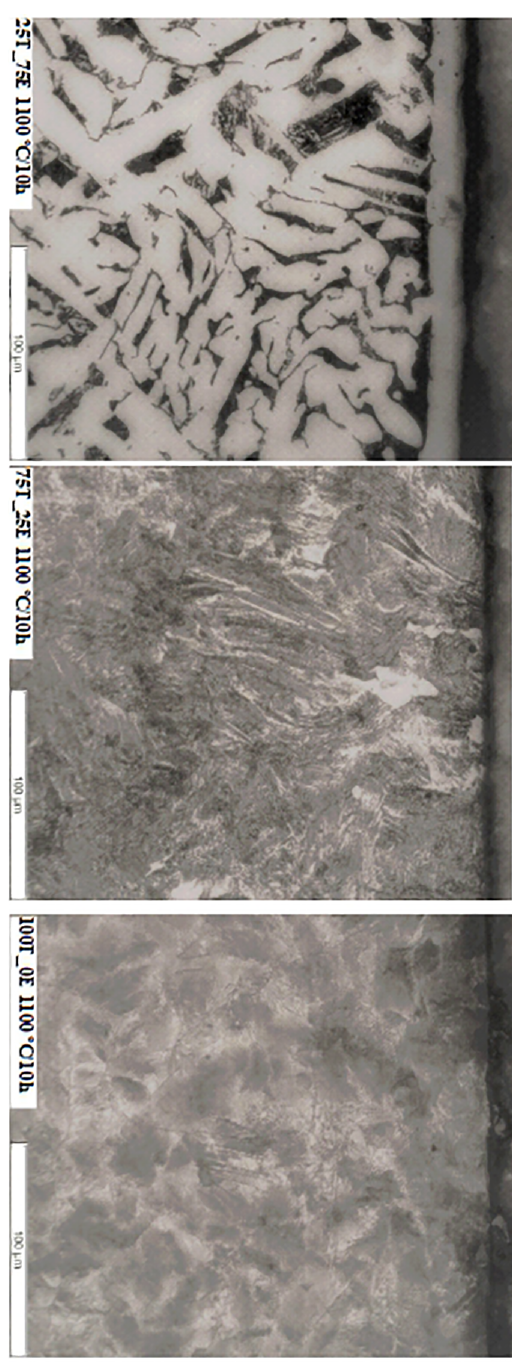
Figure 6. Cross-sections micrographs of AISI 1020 steel thermochemi- cally treated with mixtures Turbonit ® +Ekabor ® and Turbonit ® during 10 h at 1100º